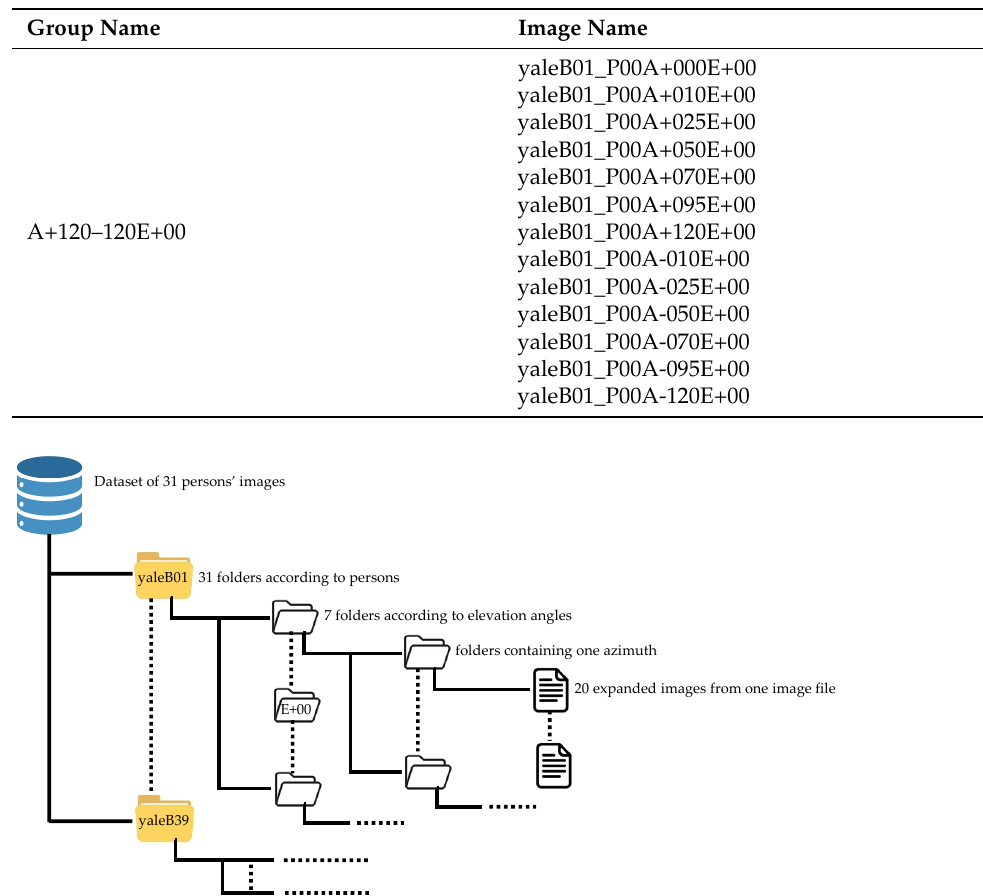
Figure 5. OpenFace nn4.small2 network structure.